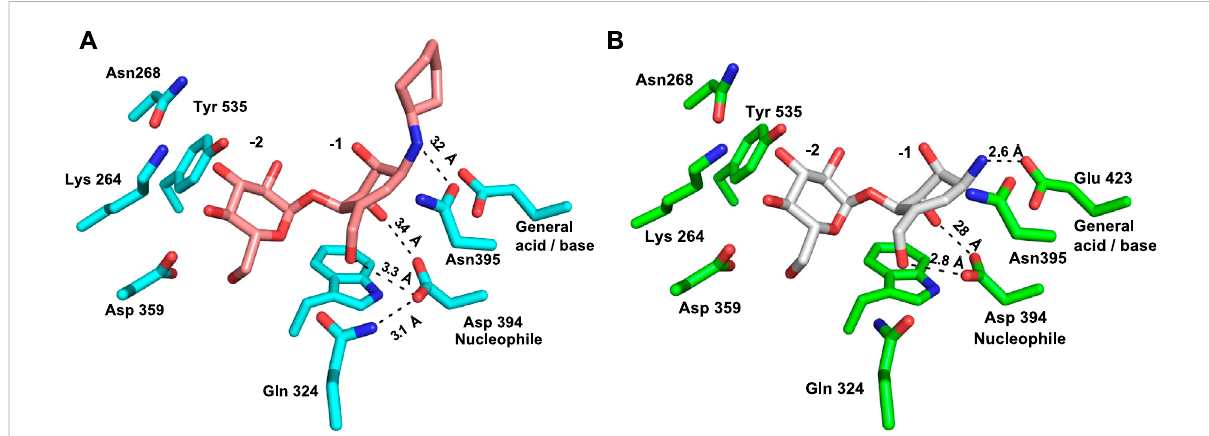
FIGURE 6 Comparison of interactions in the − 1 sites of (A) Sco GlgEI-V279S/ 13 (pink carbon atoms) and (B) Sco GlgEI-V279S/ AGV (gray carbon atoms)